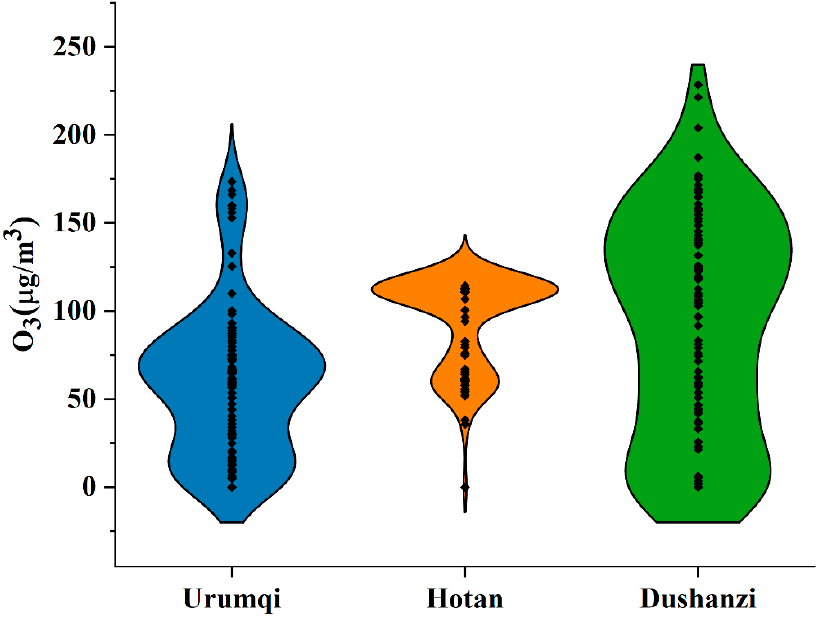
Figure 6. Simulation of ozone in the three regions of Xinjiang (Urumqi City, Dushanzi District, and Hotan City).